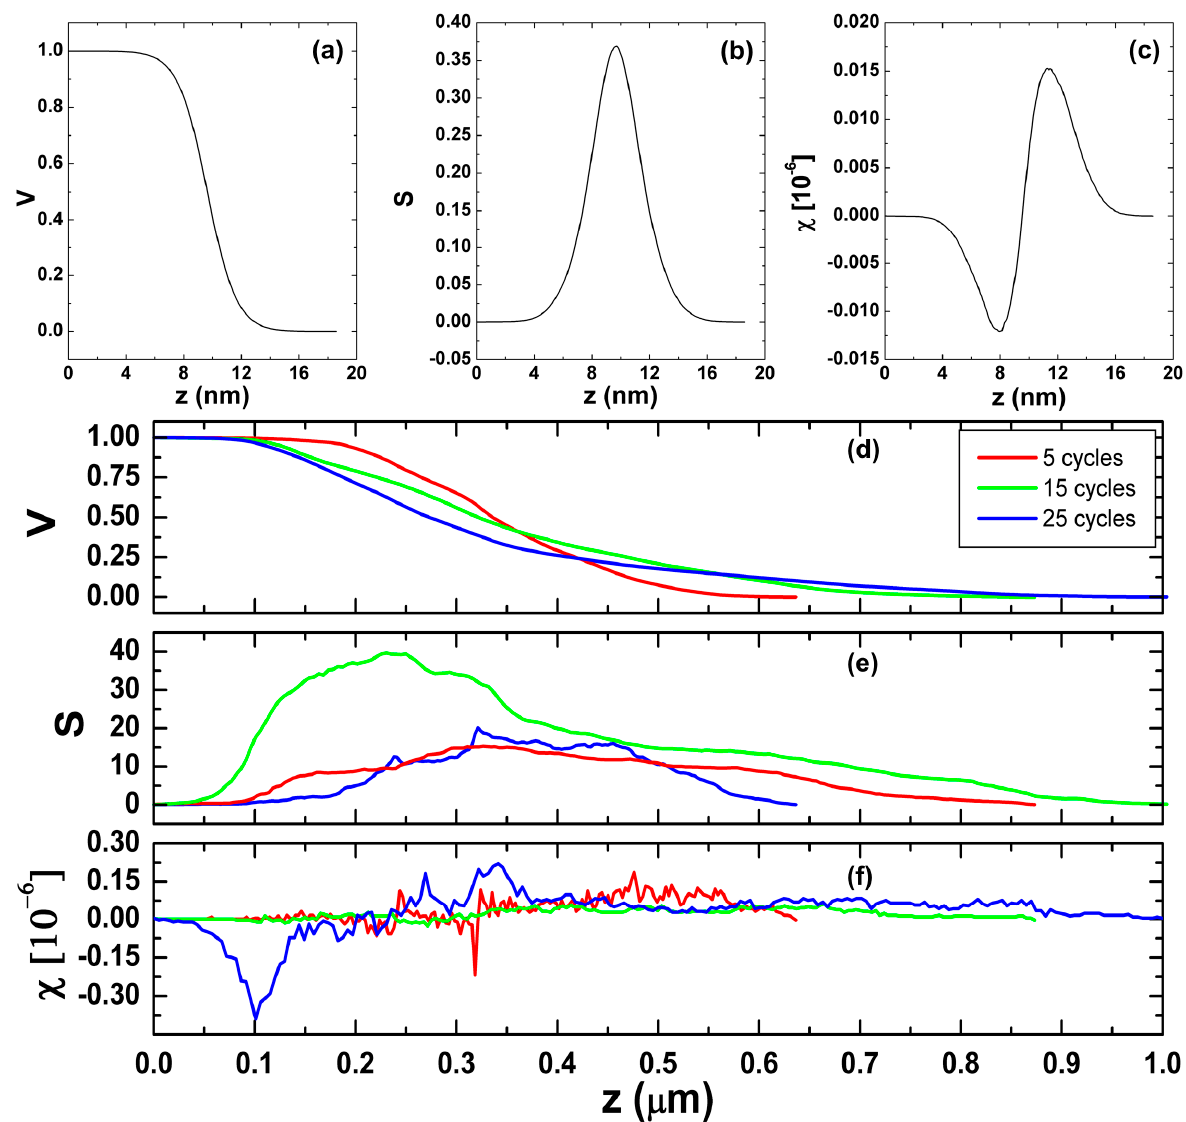
Figure 4. The Minkowski functionals of the samples: ( a ) volume, ( b ) boundary, and ( c ) connectivity for the ITO surface; ( d – f ) are, respectively, volume, boundary, and connectivity for the POEA thin films. Table 3. Values of Minkowski functionals of the POEA films surfaces.